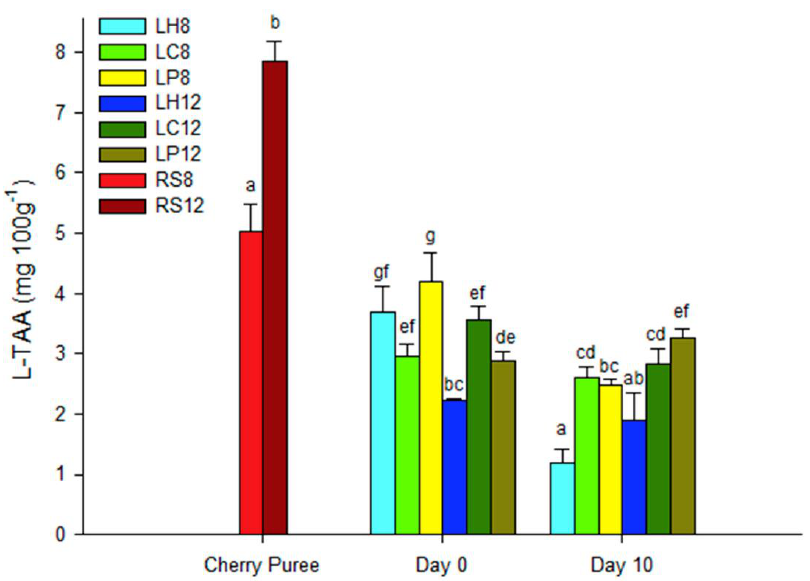
Figure 4. Total antioxidant activity due to lipophilic compounds (L-TAA) (mg 100 g −1 ) of sweet